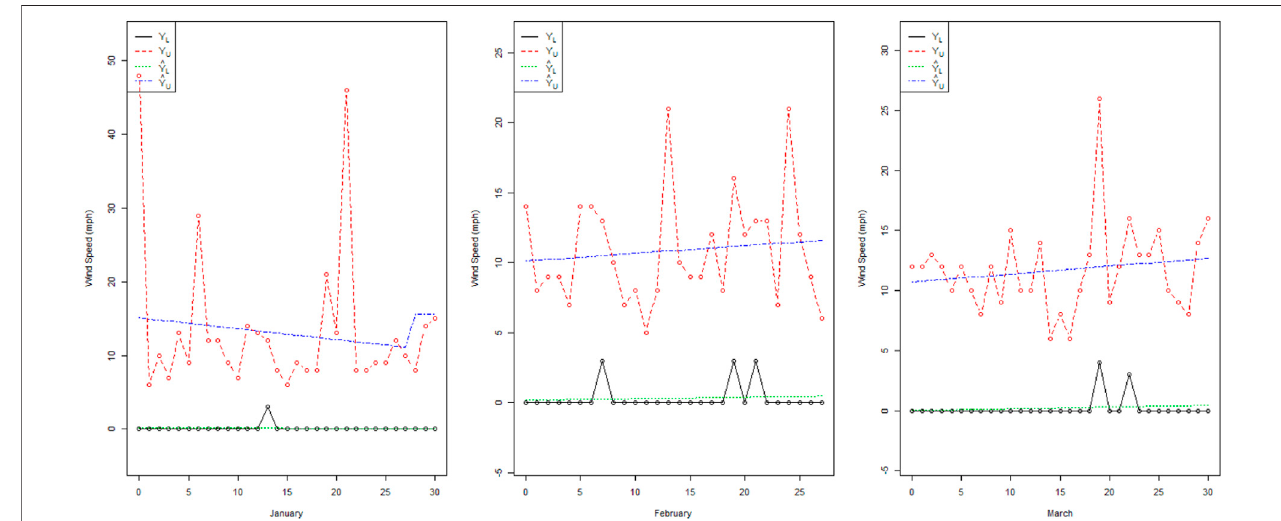
FIGURE 2 | Trended lines for January, February, and March.